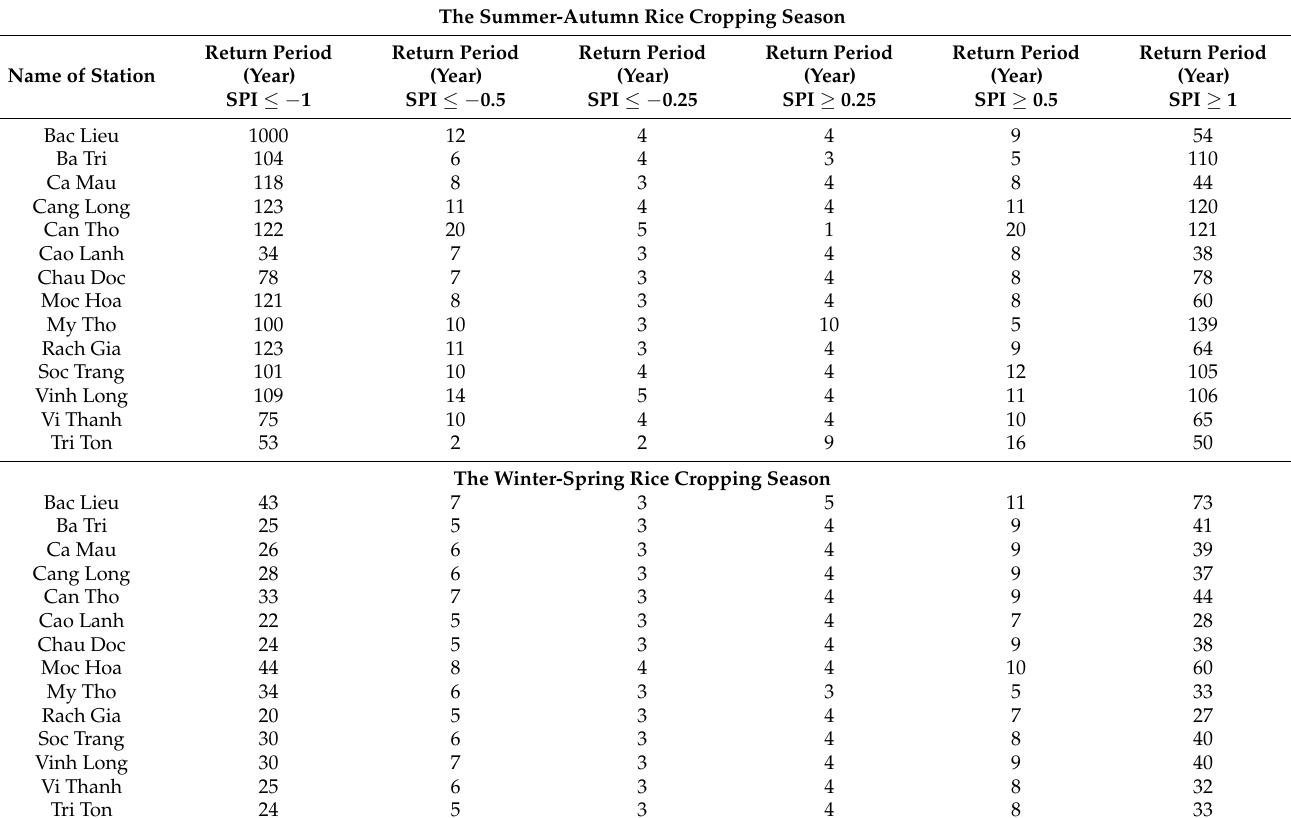
Table 2. Return period (N, year) at various drought levels for SA and WS rice cropping